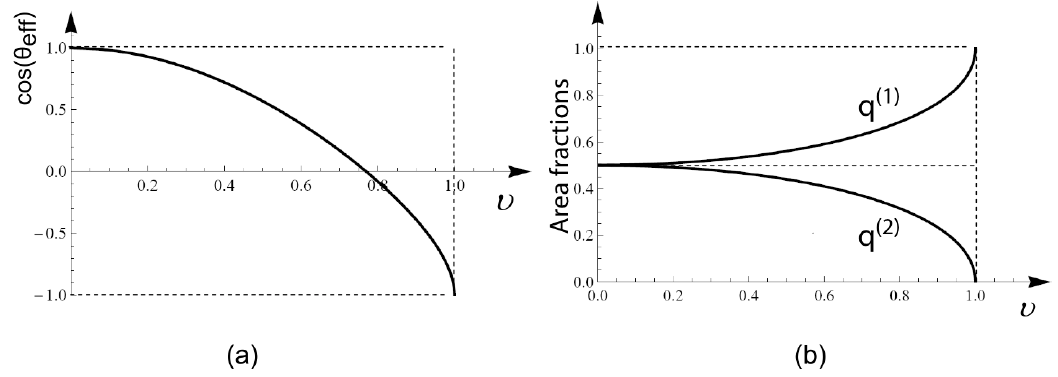
Figure A1. Spherical cap geometry: ( a ) Cosine of the effective contact angle θ ( b ) Area fractions q [1] = A [1] / A and q [2] = A [2] / A of the unbound [1] -segment and the bound [2] -segment as a function of reduced vesicle volume v